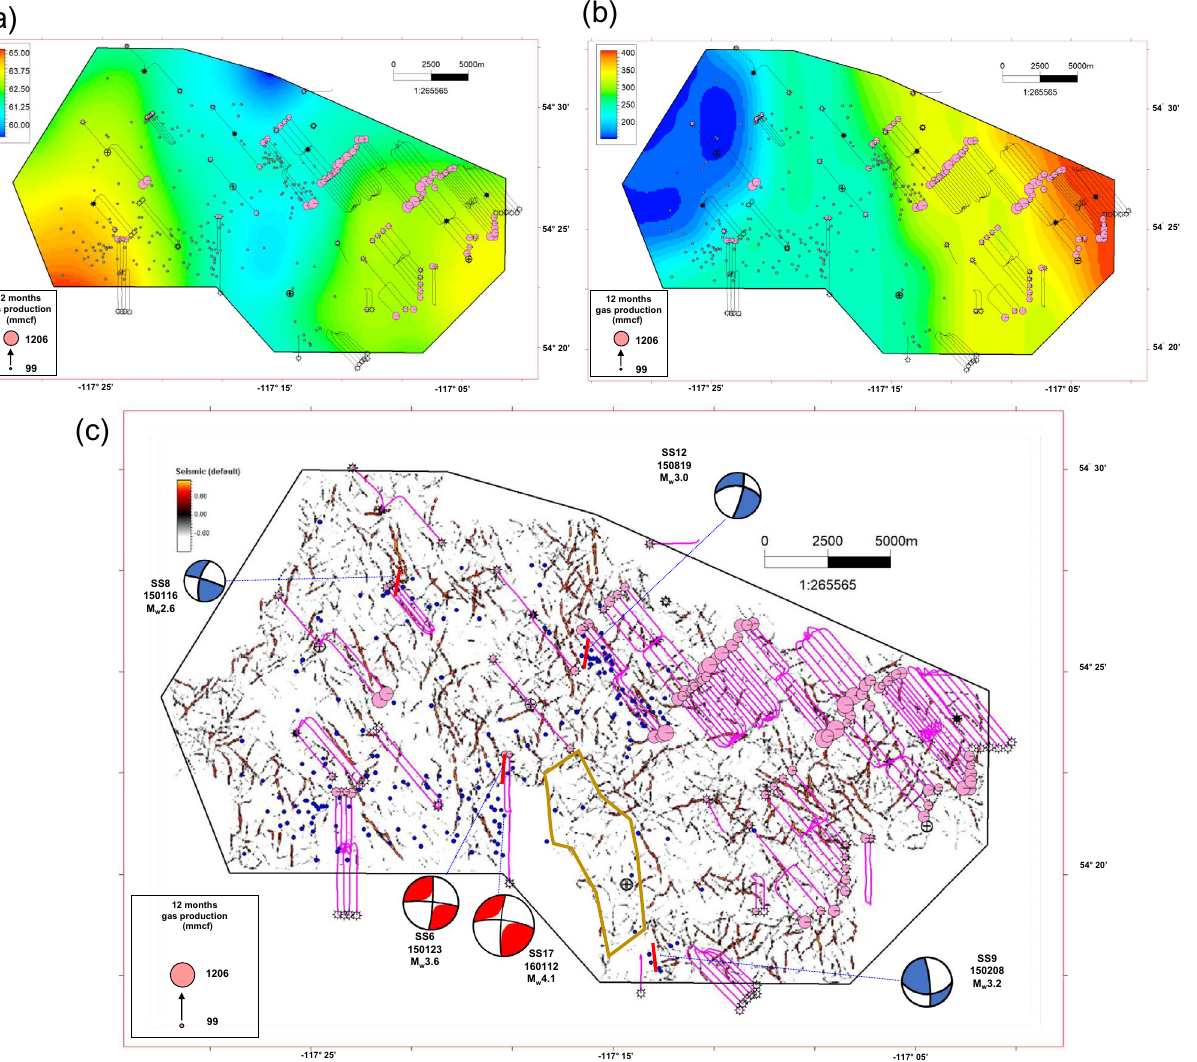
Figure 5. ( a ) Map of formation pore pressure (MPa) in the region studied. The gray and pink circles show the monitored induced earthquakes and 12-month gas production. ( b ) Map of distance (m) to Precambrian basement in the region studied. The gray and pink circles show the monitored induced earthquakes and 12-month gas production. ( c ) Map of pre-existing faults found in the Duvernay formation via the ant tracking approach. The blue circles show the monitored induced earthquakes. The brown polygon marks the optimal fracturing site, where there is a low risk of inducing